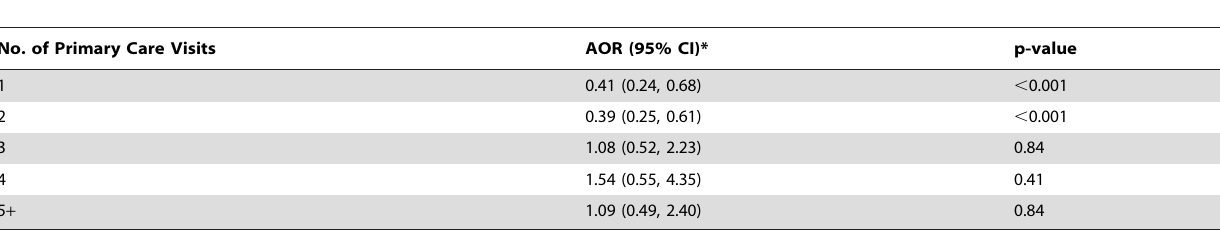
Table 5. Association Between Continuity and Emergency Department Utilization, Stratified by Total Number of Primary Care Visits.